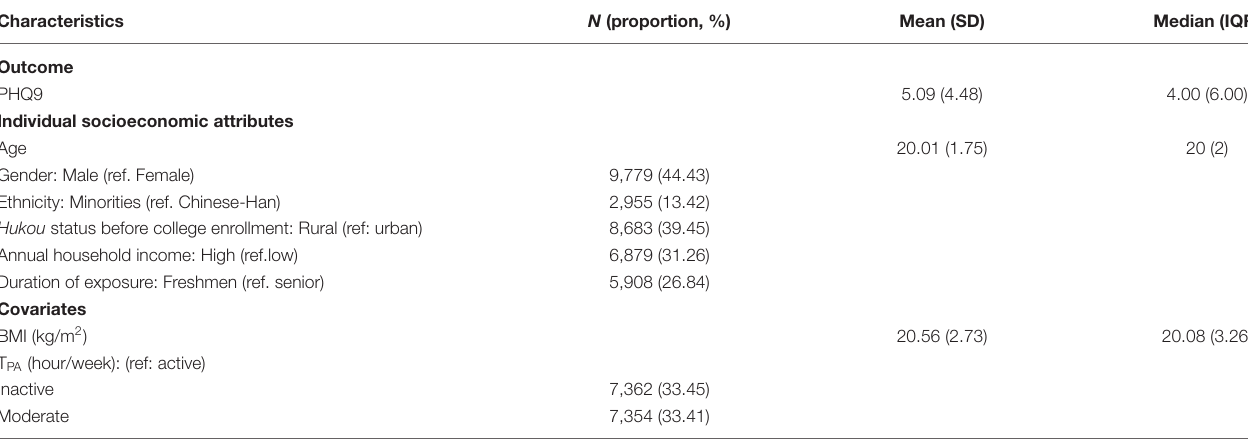
TABLE 1 | Descriptive statistics of 22,009 participants.